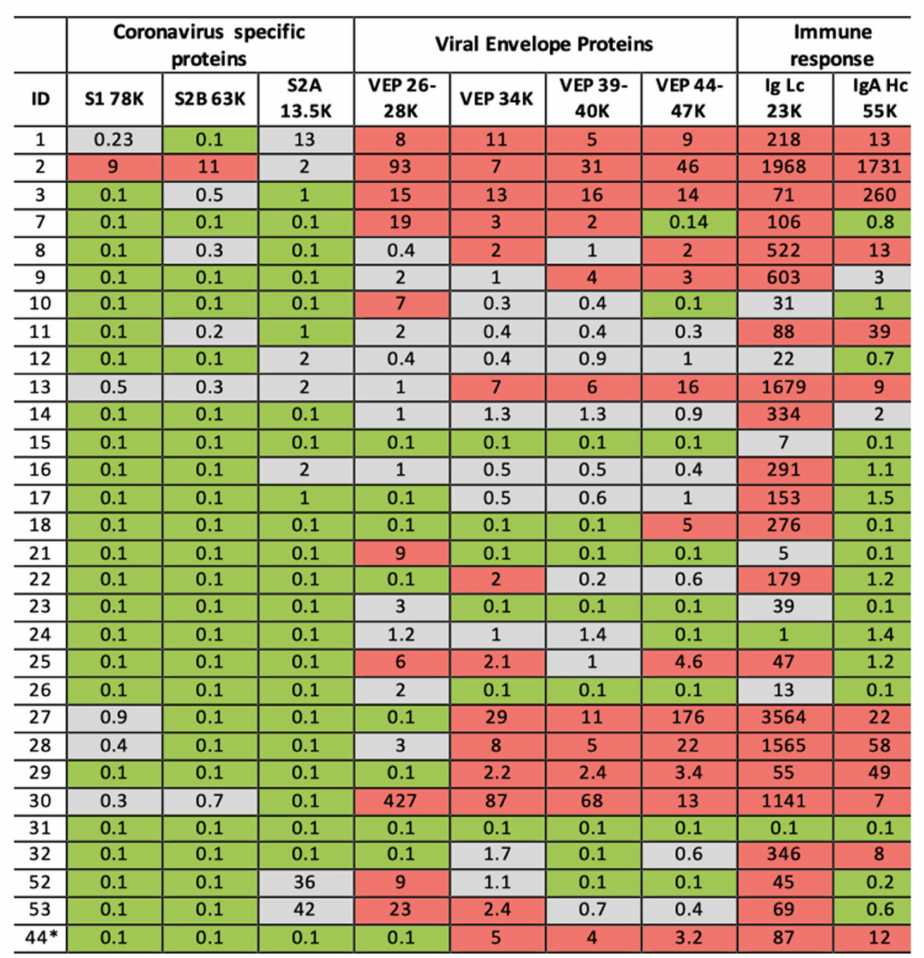
Figure 7. Illustration of clinical data output. Format is a heat map scoring of peak intensity relative to those values for SARS-2 coronavirus spike protein fragments and viral envelope proteins, measured in gargle / saliva containing 1–10% culture media of SARS-CoV-2 virus at 10 4 per ml PFU. Red indicating elevated, Grey indicating slight to moderate increase and Green indicating within normal range. Heat map associated with immunoglobulin intensities are based on the range found in the volunteers for which volunteer ID2 was identified as recovering from suspected COVID-19 infection. ID2 was repeated after 14 days and his scores are shown under ID44